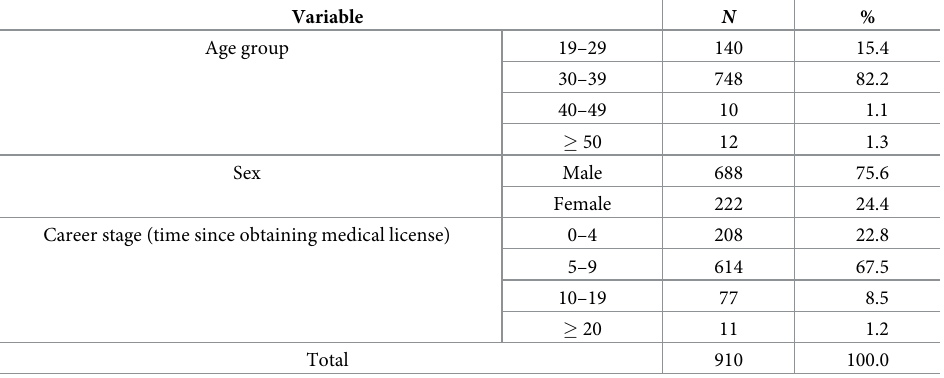
Table 1. Socio-demographic characteristics of survey